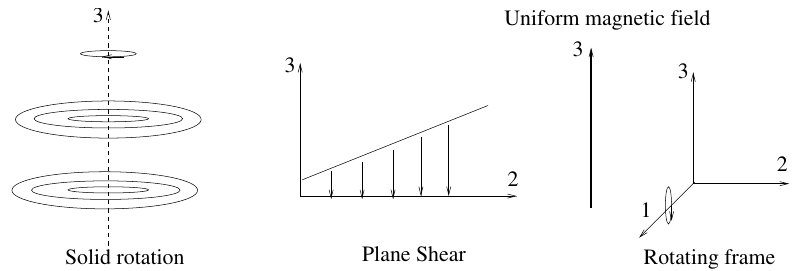
Figure 1. Sheck of base flow which corresponds to a superposition of a solid-body rotation about the vertical axis x 3 with rate Ω and a plane shear in ( x 2 , x 3 ) with rate S = 2 ε Ω in a rotating frame about the x 1 axis with rate Ω p = ε Ω under a uniform magnetic field along the vertical ( x 3 )